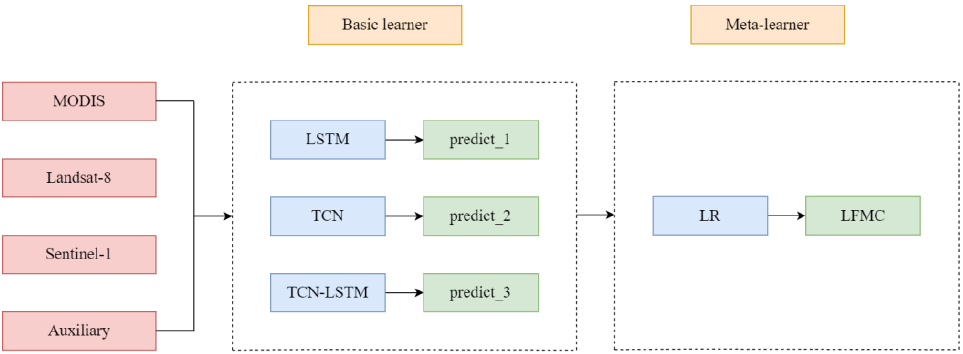
Figure 3. Structure of stacking